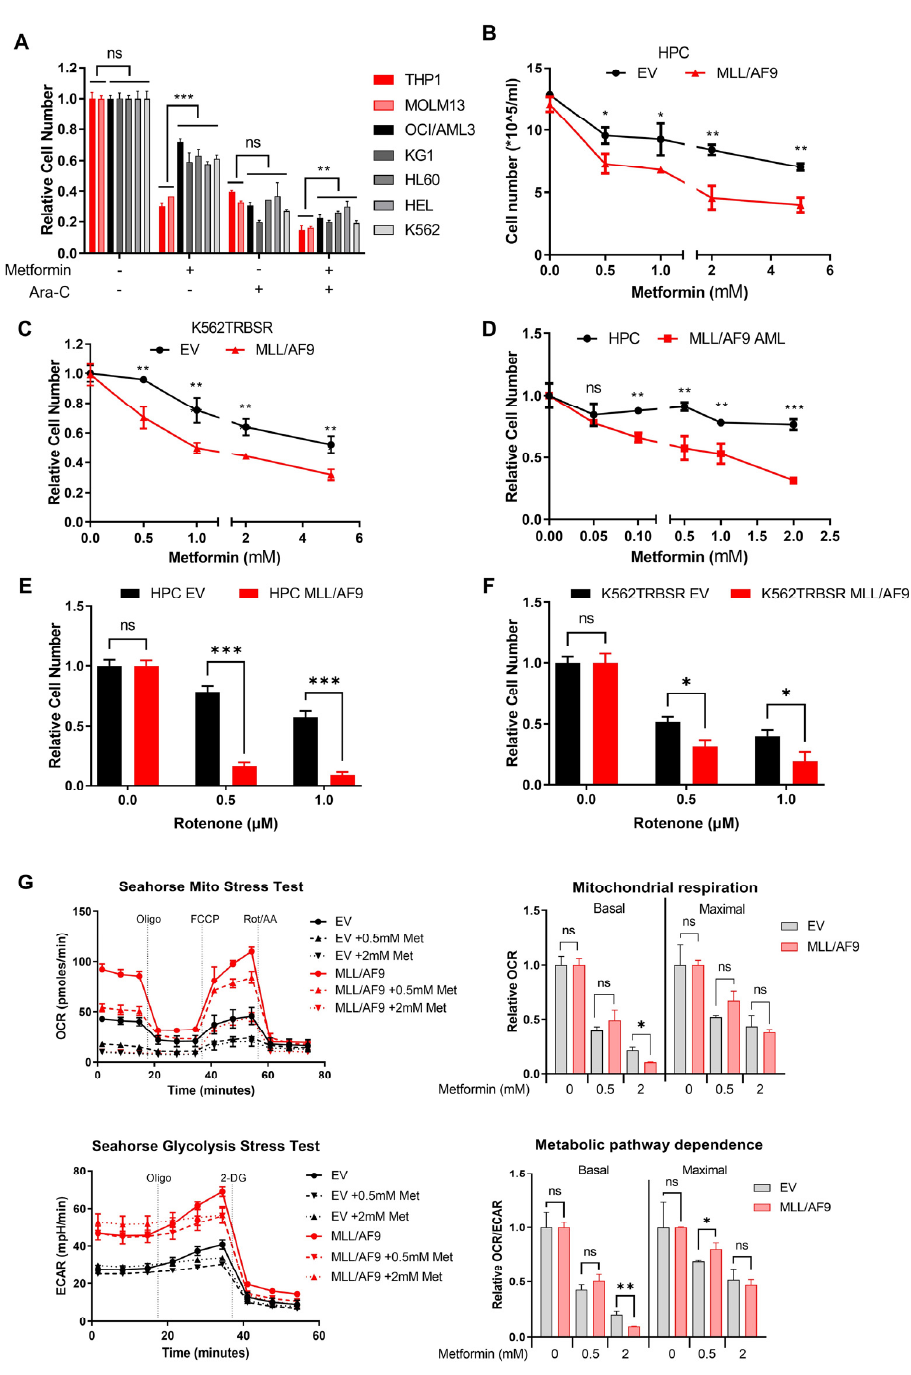
Figure 3. Evaluation of metformin-induced effects in MLL/AF9 AML. ( A ) The effect of metformin on the proliferation of various AML cell lines was determined after treating with 5 mM metformin for 72 h with or without Ara-C. Murine HPCs ( B ) or K562TRBSR cells ( C ) were transduced with EV or MLL/AF9 vector, and the proliferation rates were evaluated after 72 h treatment with metformin. ( D ) c-kit+/GFP+ blast cells from MLL/AF9 AML mice or c-kit+ HPCs from control mice were treated with metformin for 72 h, and proliferation were determined. ( n = 3 mice; three independent experiments). Murine HPCs ( E ) or K562TRBSR cells ( F ) transduced with EV or MLL/AF9 vector were treated with rotenone for 48 h, and cell numbers were determined. ( G ) Murine HPCs transduced with EV or MLL/AF9 gene were treated with metformin for 24 h, and the effect of metformin on mitochondrial respiration and glycolysis was measured by the Seahorse Flux analyzer. All data are expressed as the mean ± standard deviation. * p < 0.01; ** p < 0.01; *** p < 0.001 (Student’s t -test).